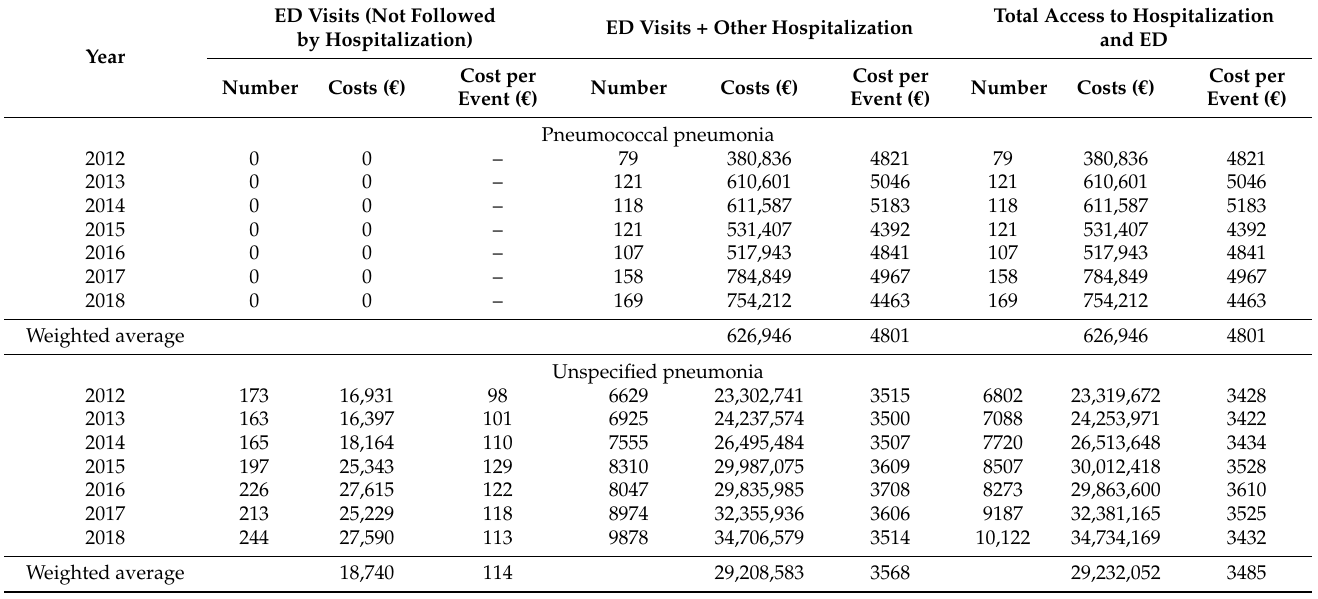
Table 3. Healthcare resource utilization and costs for specified and unspecified pneumonia for individuals ≥ 15 years of age in the Liguria region 2012–2018.